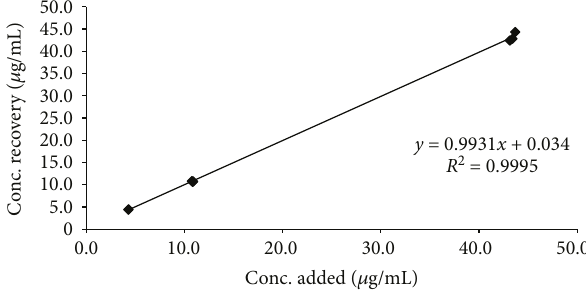
Figure 9: Accuracy for ketorolac in wastewater. Table 6: Accuracy results for ketorolac in the degradation